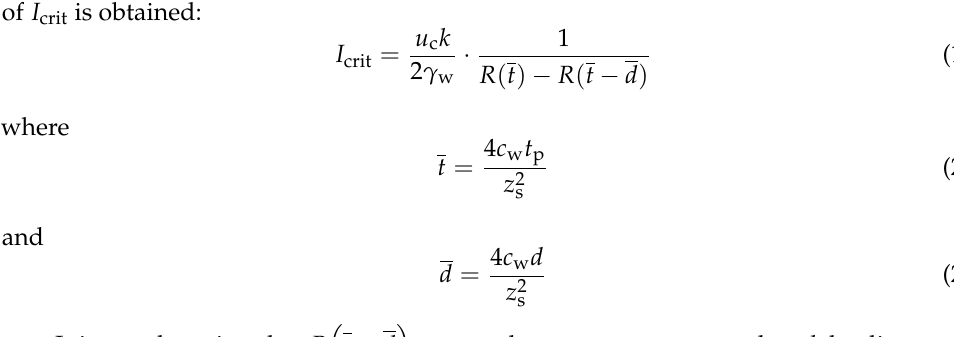
Figure 5. Flow chart illustrating the use of the proposed method. The critical duration, c d , is cal- culated using Equation (19) in which pI = crit is imposed. 3. Application of the Method In this section, the proposed method is applied to analyze two case studies docu- mented in the literature. The first case study is drawn from a paper by [50] and concerns a rainfall-induced shallow landslide occurred in a site near the city of Bologna (Northern Italy). The slope can be schematized as an infinite slope with an average inclination α = 14°. It was affected in the past by landslide movements that involved an inorganic clay with high plasticity [51]. Two failure surfaces were localized at the depths (measured in the vertical direction)